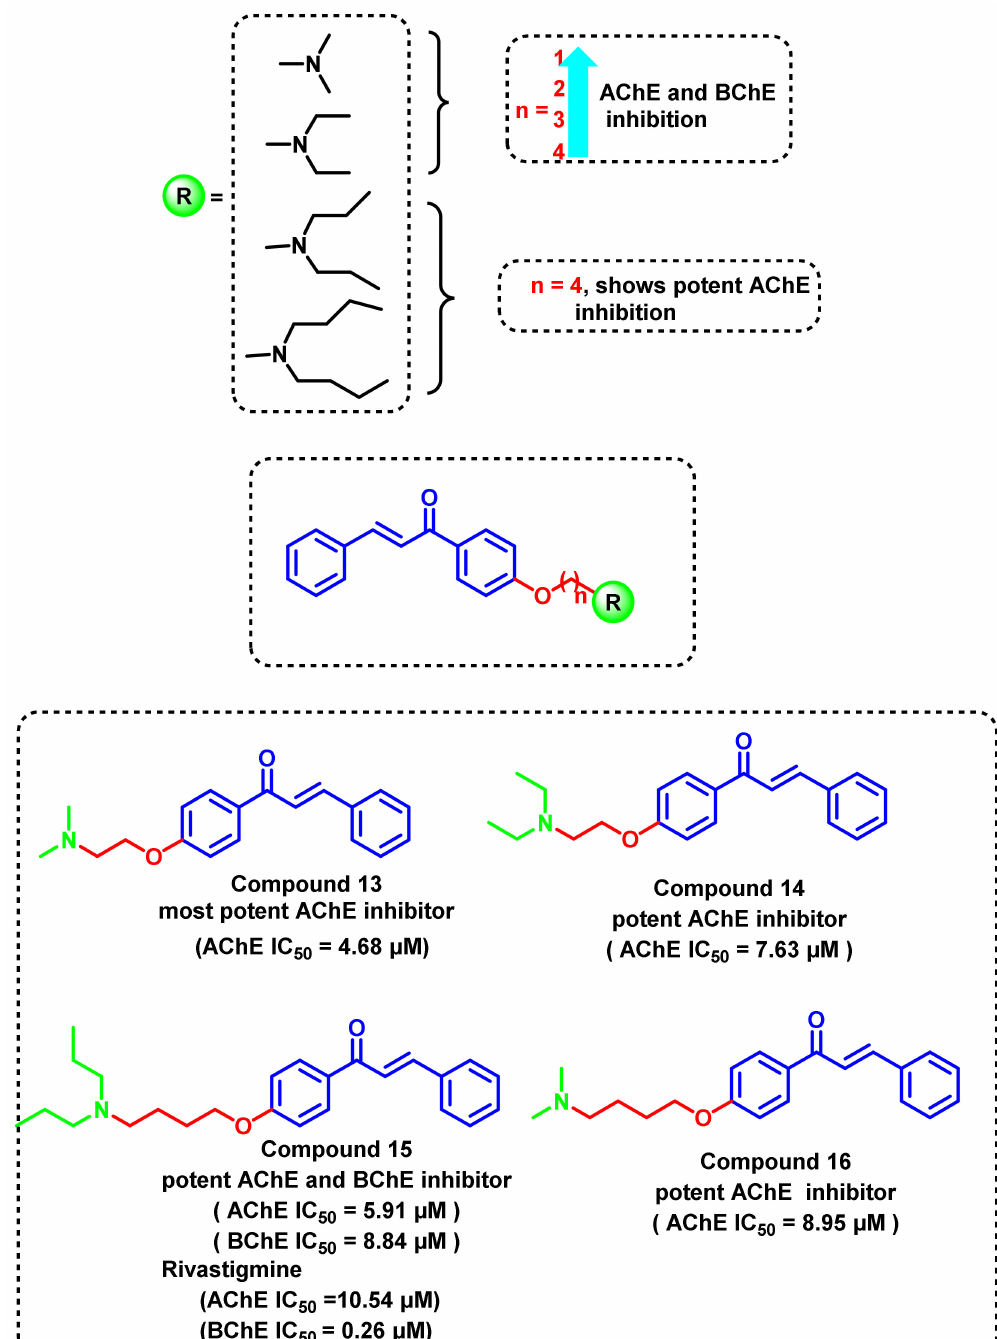
Figure 18. Open-chain amino alkyl chalcone